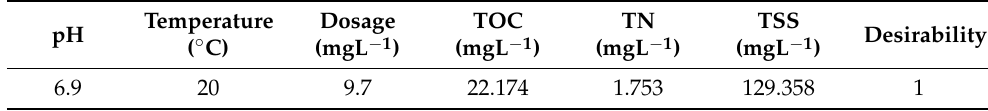
Table 5. Optimized condition for TOC, TN, and TSS